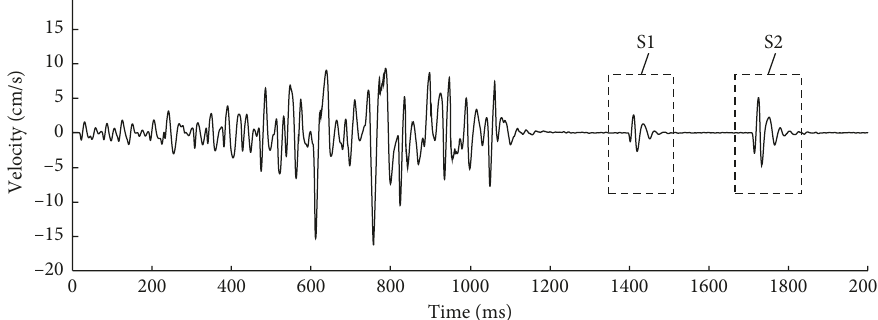
Figure 26: Typical blast vibration waveform in the production blasting